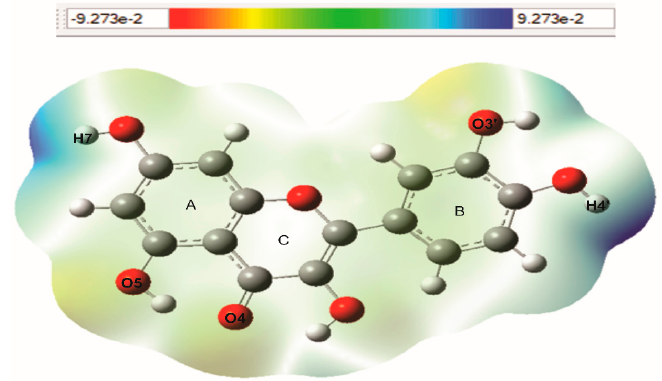
Figure 2. Molecular electrostatic potential (MEP) map of quercetin (Q), calculated with B3LYP/6-31G (d,p) methodology. Processes 2020 , 8 , x FOR PEER REVIEW 8 of 16